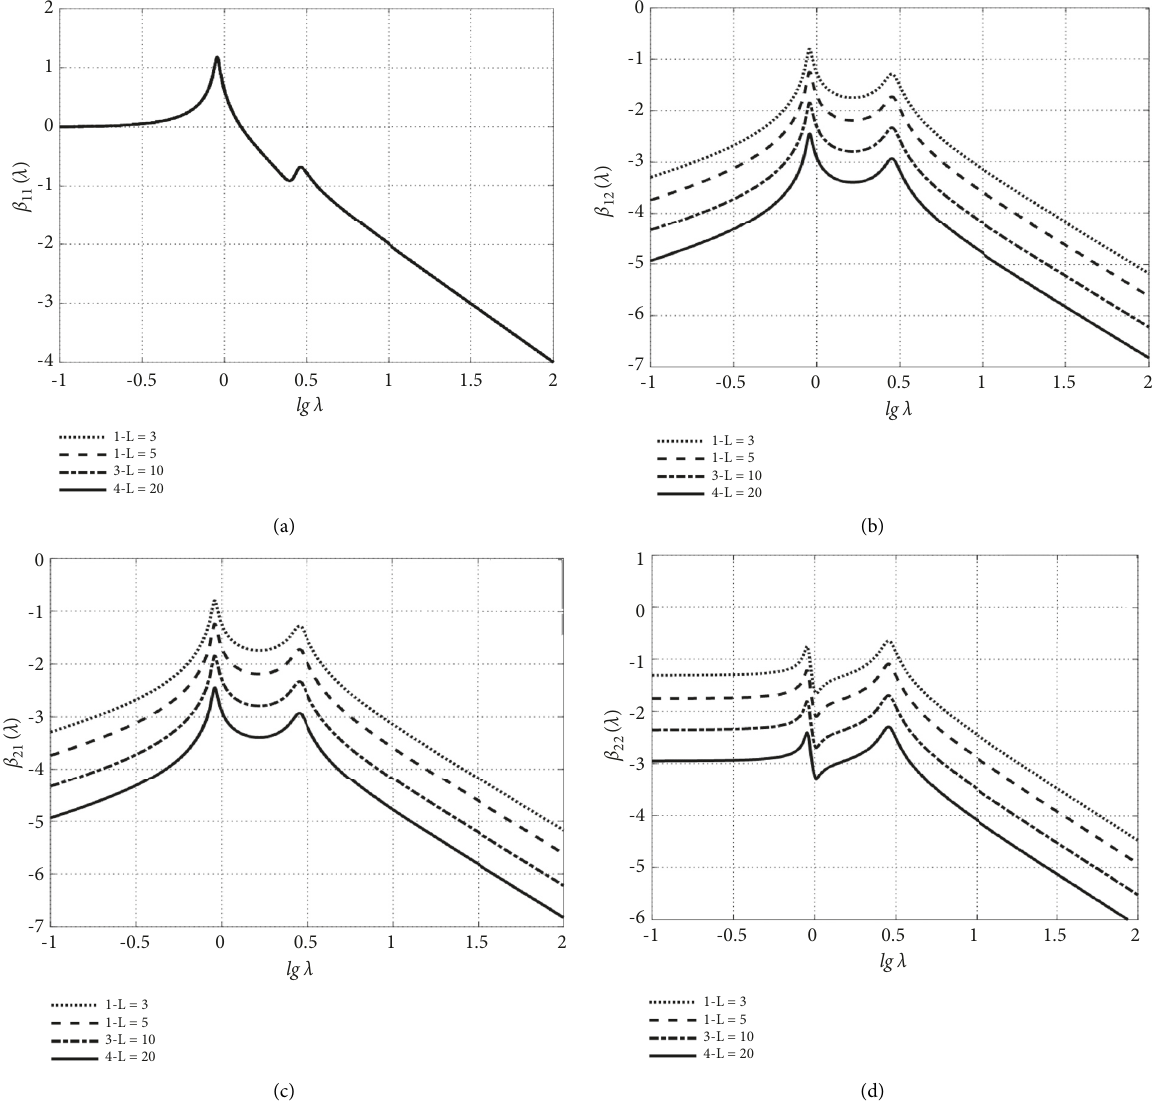
Figure 3: Logarithmic dynamic amplification factor under different vibration slab length changes.(a) logarithmic dynamic amplification factor β 11 (b) logarithmic dynamic amplification factor β 12 . (c) logarithmic dynamic amplification factor β 21 (d) logarithmic dynamic amplification factor β